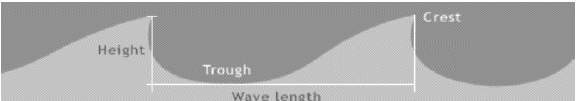
Figure 3. Example of wave dimensions (National Weather Service, 2017)